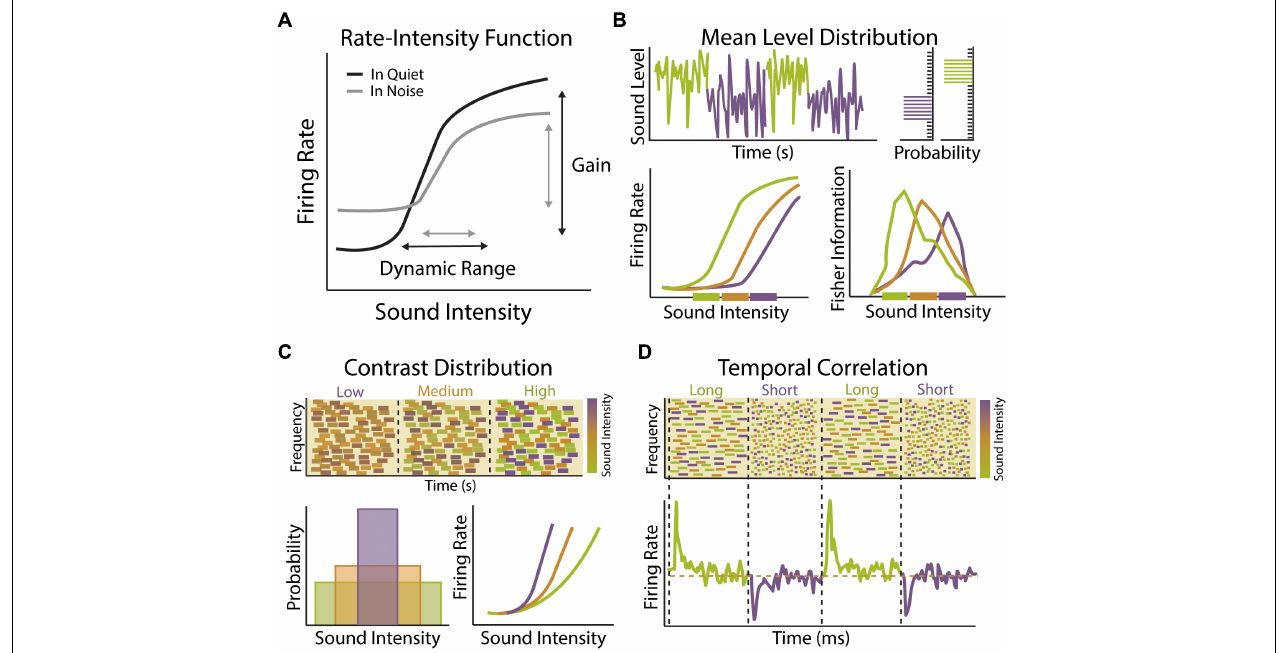
FIGURE 1 | Stimulus statistic adaptation in the auditory system. (A) Example rate-intensity function showing input–output relationship of sound intensity and auditory neuron firing rate in quiet (black) or in the presence of background noise (gray). Auditory neurons encode sound level information through changes in mean firing rate. The neuron’s response gain is defined as the rate at which neuronal firing increases as a function of increasing sound level input. The dynamic range of a neuron is defined as the range of stimulus values encoded by a neuron though changes in its firing rate. A majority of auditory neurons exhibit low thresholds with firing rates that saturate to low or moderate sound levels, limiting their dynamic range. Both the gain and dynamic range of auditory neurons become compressed in the presence of background noise, which can be compensated for in part by adaptation to sound level statistics. (B) Example of dynamic range adaptation in a central auditory neuron or auditory nerve (AN) fiber. Top: Switching stimulus with high probability density region (HPR) at low (green) or high (purple) sound intensity levels. Within each environment, the range of intensities is drawn from a statistically defined high probability region confined to a narrow range of intensity while the remaining stimuli are drawn from a broader range of intensities outside the HPR (top right). Bottom: Auditory neurons adapt their threshold and dynamic range so that they are most sensitive to sound intensities within in the HPR, indicated by thick colored bars on x -axis (bottom left). Fisher information measure of coding accuracy for rate-intensity functions indicates that dynamic range adaptation acts to improve accuracy of sound intensity coding for sound levels most likely to be encountered in current environment (bottom right). Schematized data adapted from Dean et al. (2005). (C) Example of contrast gain control in a central auditory neuron. Top: Spectrogram of dynamic random chord (DRC) stimuli with low, medium or high contrast in sound intensity levels. Bottom: Theses spectrotemporally complex stimuli have same mean sound level but different sound level variance (bottom left). Neuronal gain shifts with changes in contrast (bottom right). Response gain is steep in low contrast environments (purple), allowing neurons to be sensitive to small changes in sound intensity, but becomes progressively shallower in medium (orange) and low (green) contrast environments, allowing neurons to maintain sensitivity to a larger range of intensities. Schematized data adapted from Rabinowitz et al. (2011). (D) Example of gain adaptation to changes in temporal correlation of sounds in central auditory neuron. Top: A series of DRCs with dynamically changing temporal correlation structure. Bottom: Auditory neurons respond to transition in temporal correlation structure by brief increases or decreases in firing rate, followed by steady state firing rates (orange dashed line). These transient changes in firing rate are indicative of adaptation to statistical change in stimulus, indicating that auditory neurons can adapt to the temporal dynamic range of the inputs to preserve encoding efficiency under varying statistical constraints without changing overall activity levels. Schematized data adapted from Natan et al.